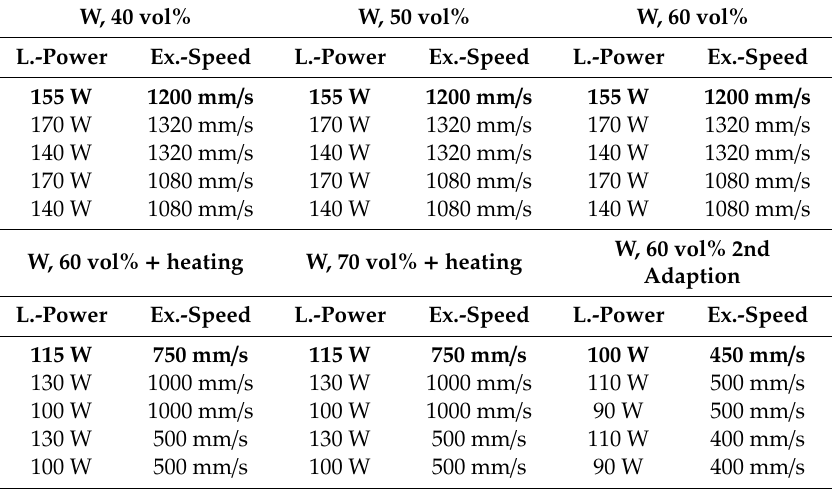
Table 1. Experimental plans for the development of suitable process parameters. Hatching distance is set constant. Central points are fabricated three times and are marked in bold font. Each experimental run is executed fully